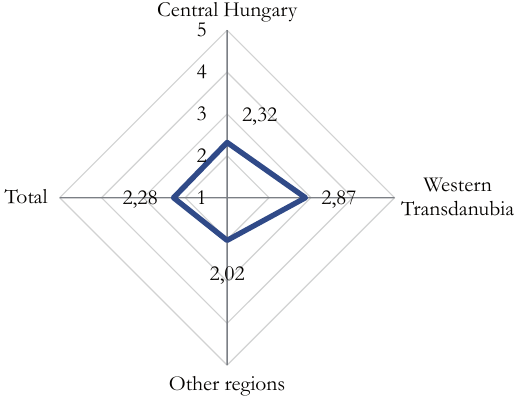
Fig. 3 – The level of difficulties to corporate governance system (1-5) Source: own compilation